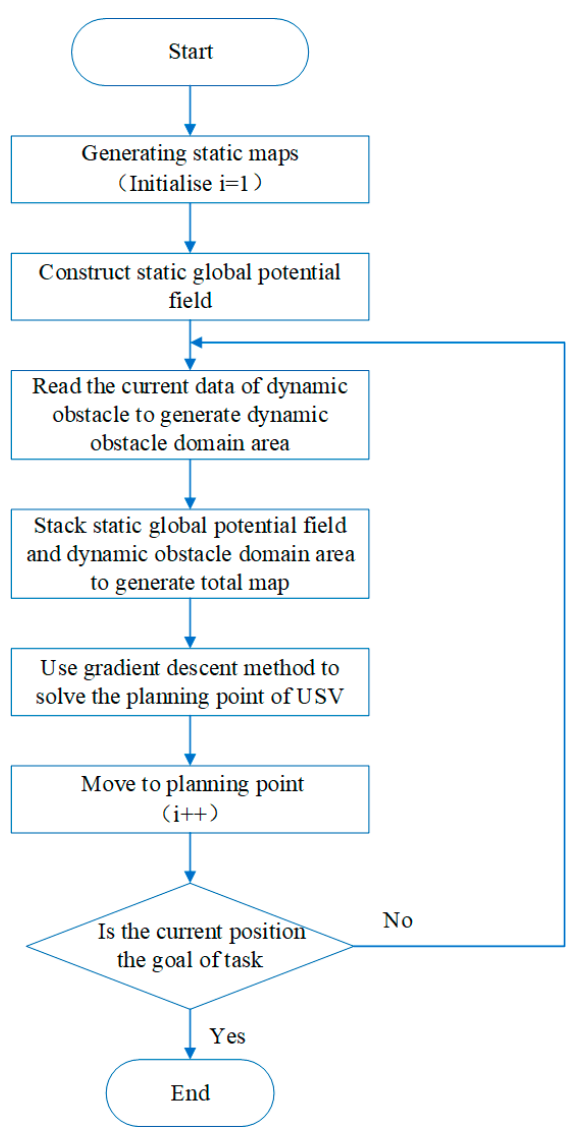
Figure 12. LSM path planning algorithm.